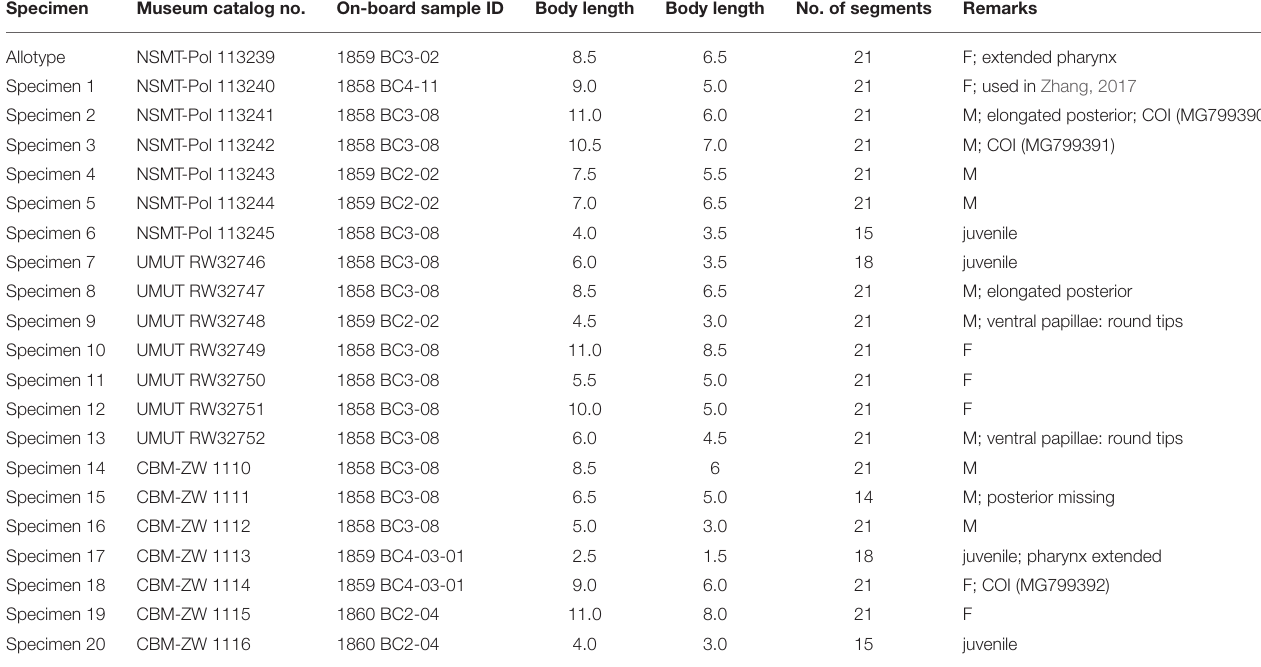
TABLE 3 | General information of examined specimens of Branchinotogluma japonicus .